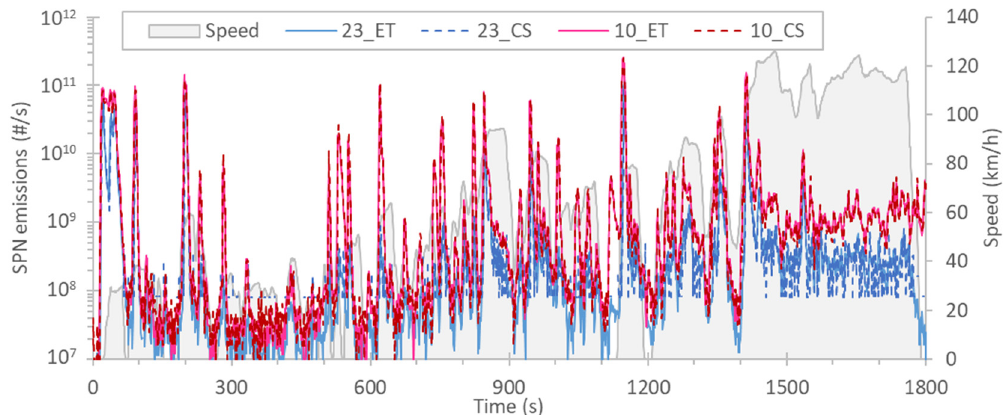
Figure 6. Real time solid particle number (SPN) emissions with the systems with evaporation tube (ET) and catalytic stripper (CS) from 23 nm or 10 nm.